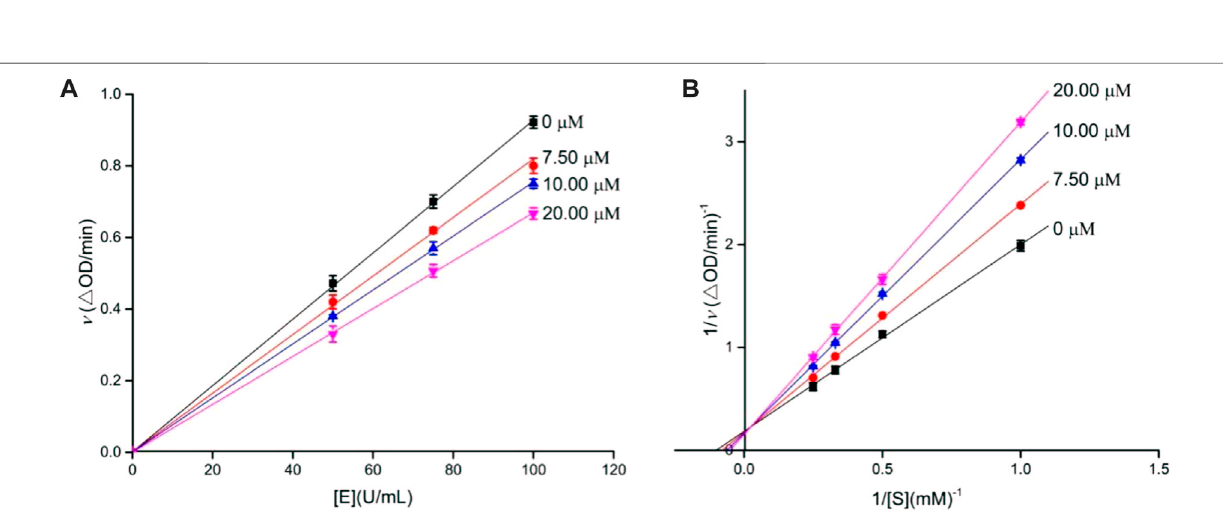
FIGURE 2 | Inhibition kinetics of analog 4o against α -amylase. (A) Plots of enzymatic reaction rate vs. α -amylase concentration with or without the presence of analog 4o ; (B) Lineweaver – Burk plots of enzymatic reaction rate vs . substrate concentration with or without the presence of analog 4o